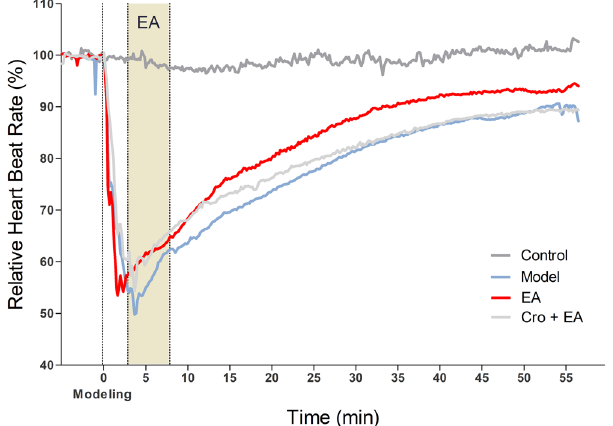
Figure 5. Average relative heart rate in different groups (n = 5–6). The heart rate was recorded in each animal by ECG. The average of every 10 s was calculated. The average relative heart rate in each group is shown with different colours. Intravenous pituitrin was injected to induce bradycardia 5 min after recording (indicated as “Modelling”, dashed line). EA was applied at PC 6 at 3 min after modelling (shadow area).